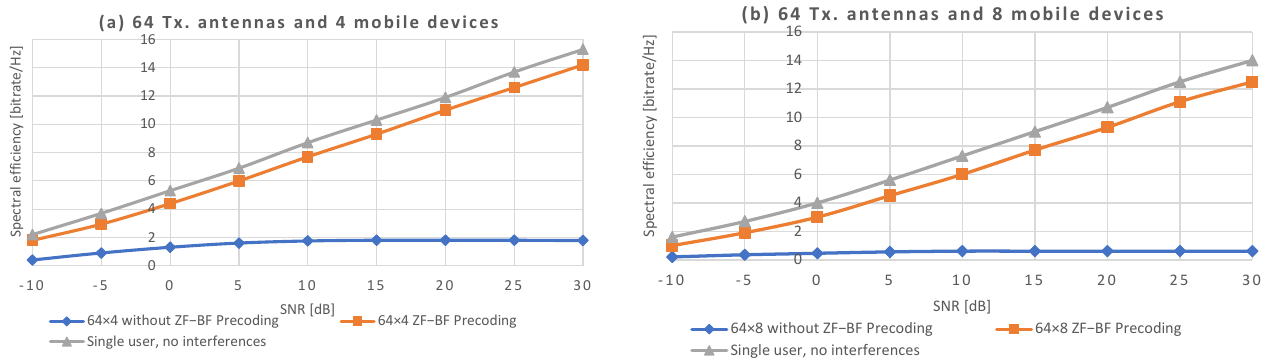
Figure 4. Comparison of ZF-BF precoding transmission and transmission without ZF-BF precoding: Achievable spectral efficiency for varying SNR in the range [ − 10; 30] dB with several transmission antennas and number of users’ mobile devices: ( a ) 64 Transmission antennas and 4 mobile devices; ( b ) 16 Transmission antennas and 8 mobile